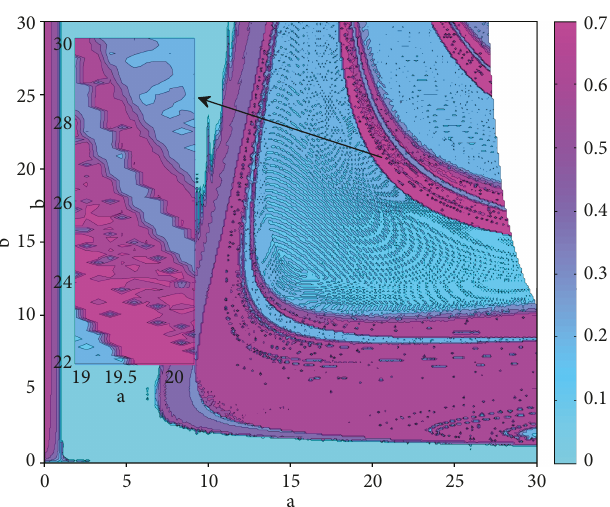
Figure 6: The spectral entropy complexity of system (2) with δ = 0 02 in the a − b parameter plane.